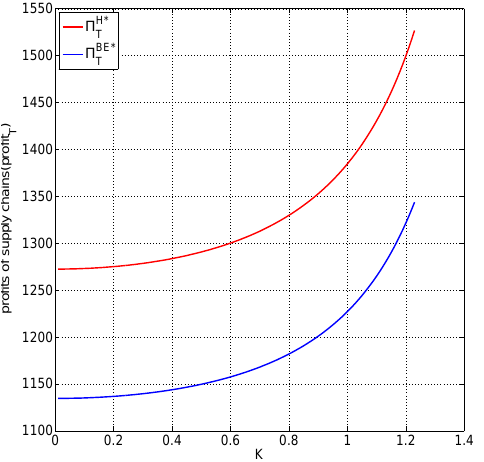
Figure 9. The influences of K on the total profit of the supply chain Π T